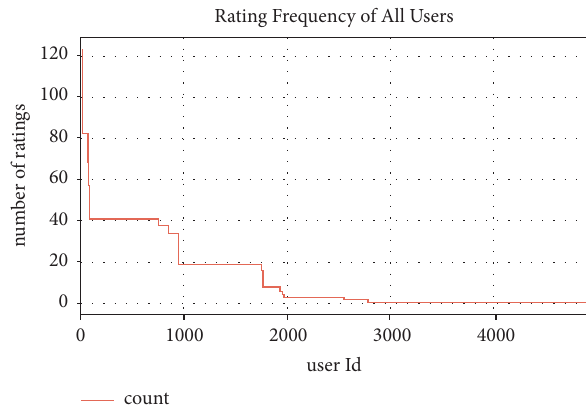
Figure 3: Rating frequency of all users.